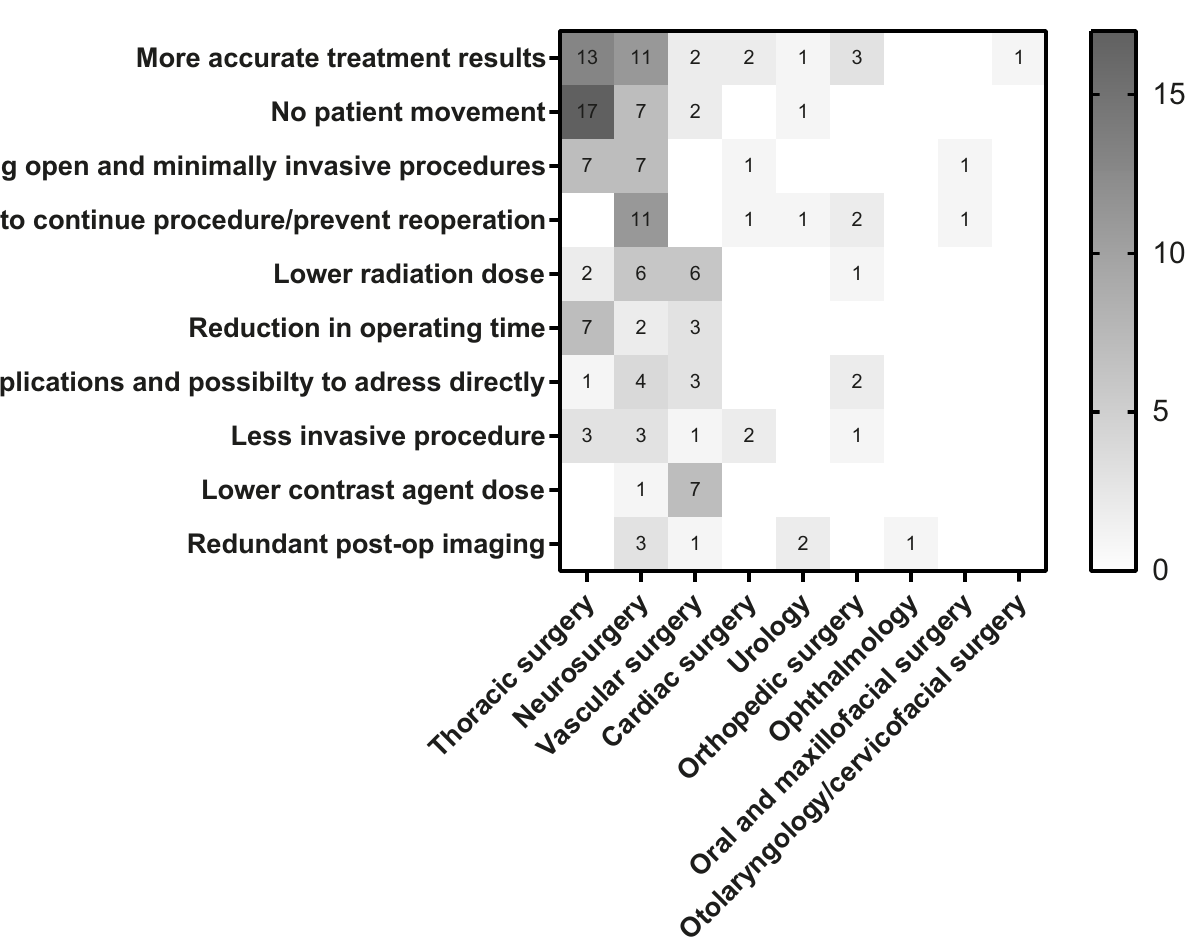
Fig 3. Overview of the advantages mentioned by the studies per clinical discipline. The numbers and grayscale indicate how many studies mentioned the advantage.